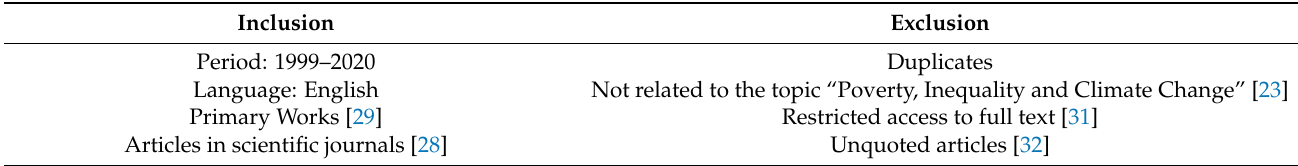
Table 1. Inclusion and exclusion